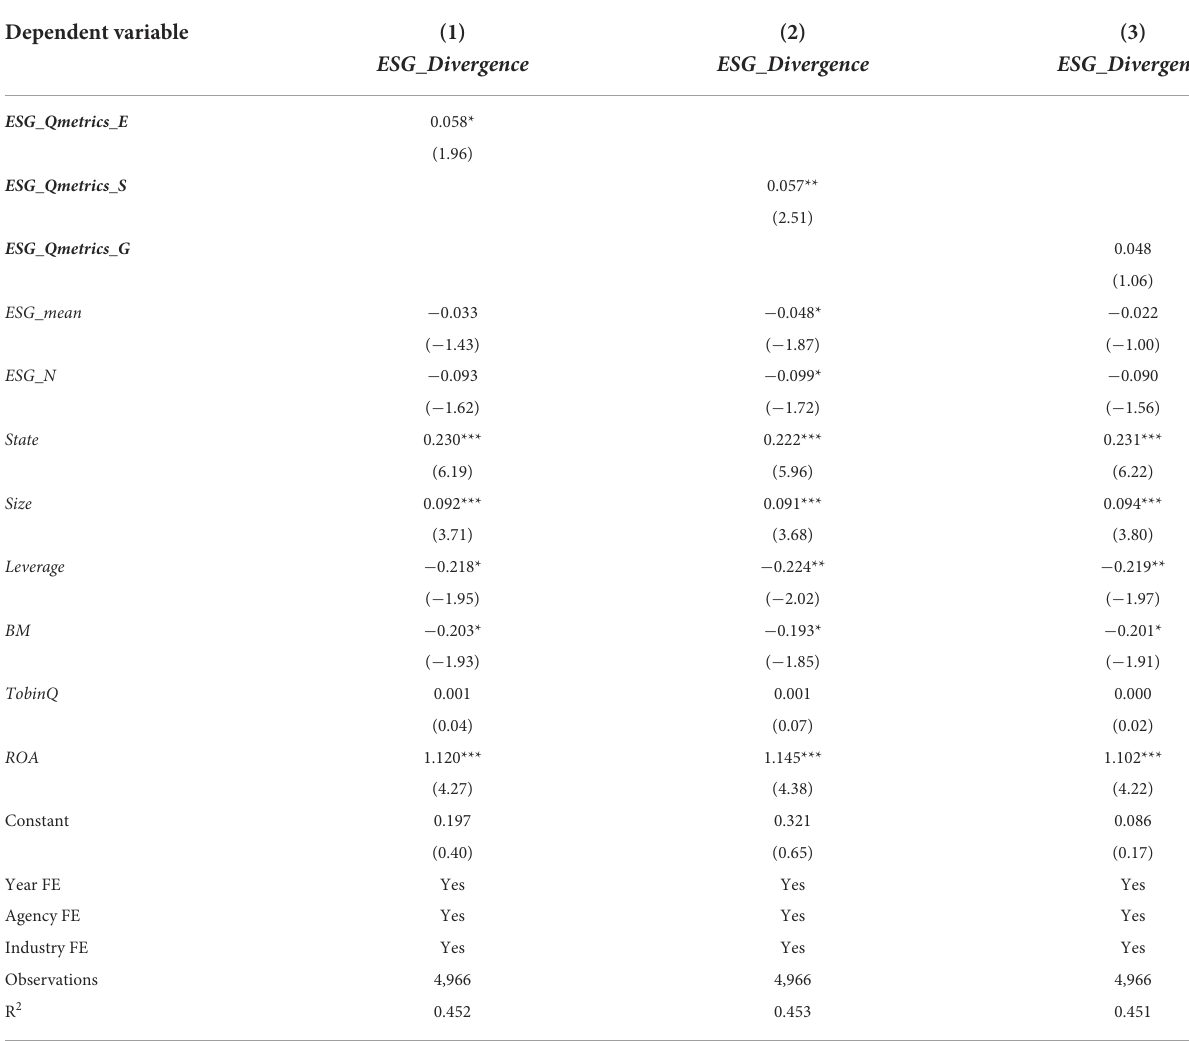
TABLE 4 Effect of E/S/G pillar-specific quantitative disclosure on ESG ratings